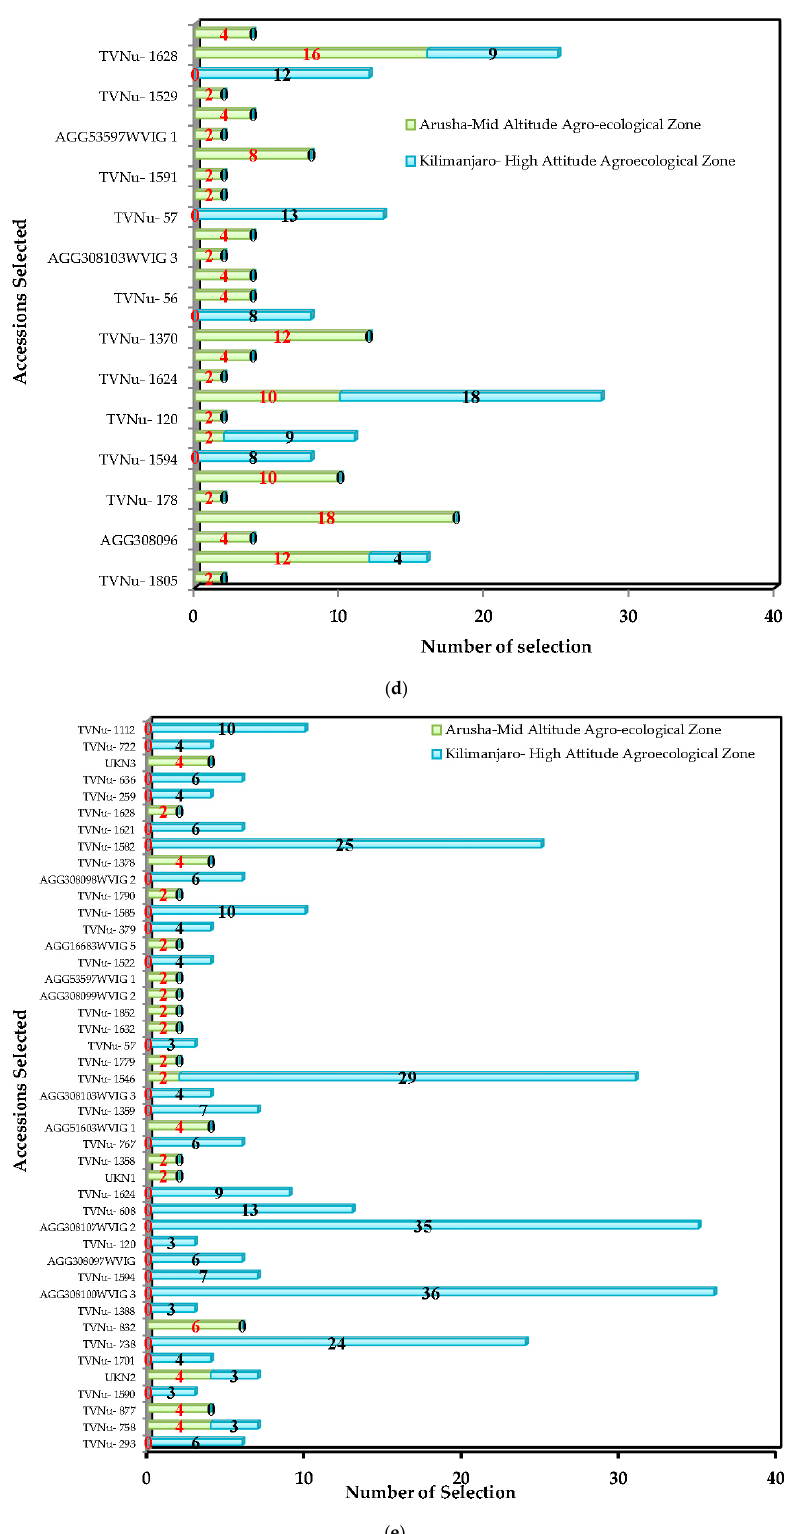
Figure 7. ( a ) Wild Vigna legumes suggested as a human food; ( b ) Wild Vigna legumes suggested as animal feed; ( c ) Wild Vigna legumes suggested as forage; ( d ) Wild Vigna legumes suggested as cover crop; and ( e ) Wild Vigna legumes given specified uses.